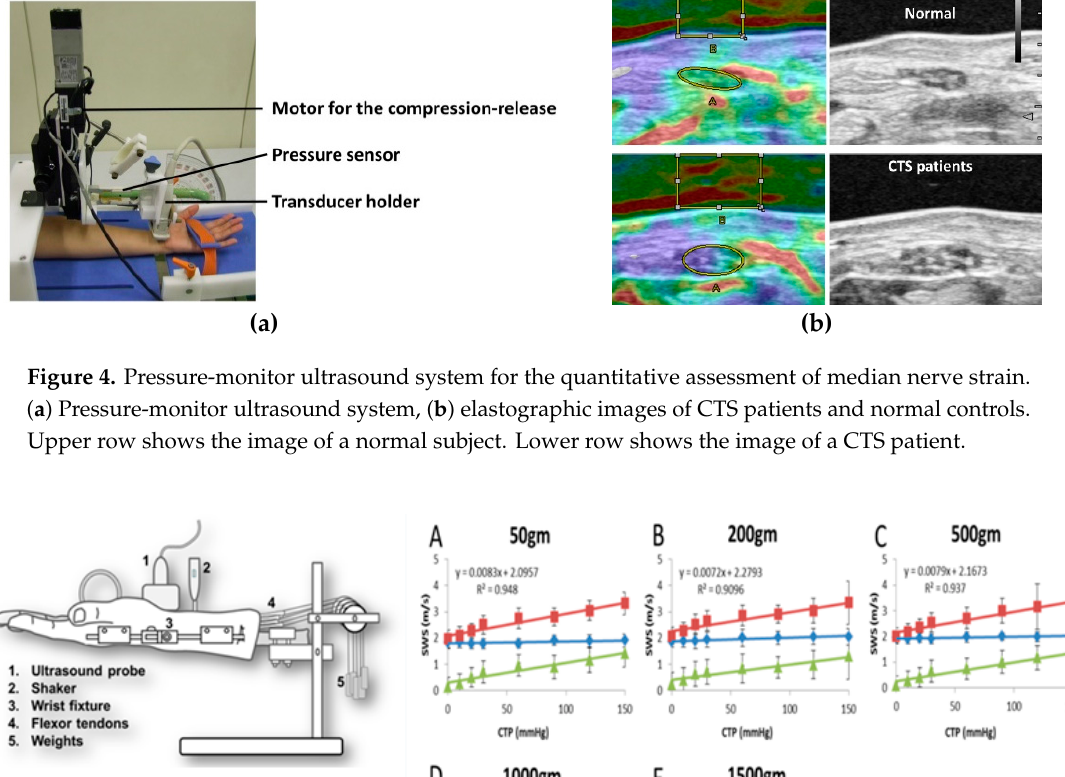
controls. Upper row shows the image of a normal subject. Lower row shows the image of a CTS patient.